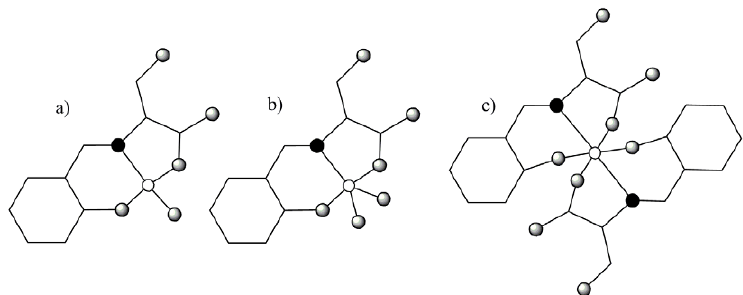
Figure 1. Graph representations of salicylideneserine complexes: a) Ni or Zn mono -complex,; b) Cu mono -complex; c) Ni or Zn bis -complex. Heteroatoms are marked with (M), (N),